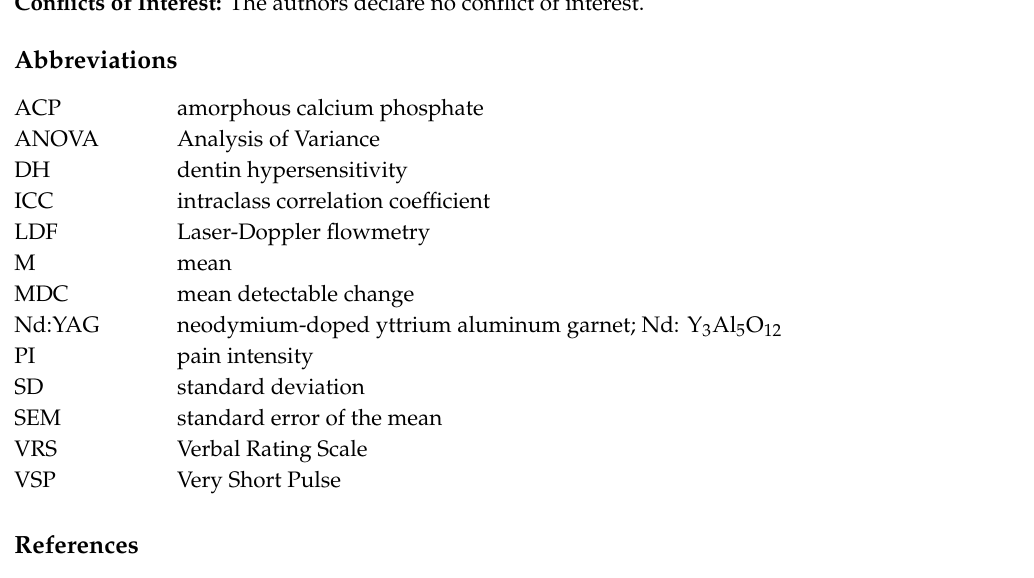
Table S1: Laser-Doppler flowmetry measurements for the 36 teeth (1.5 min dental blood flow mean values and standard